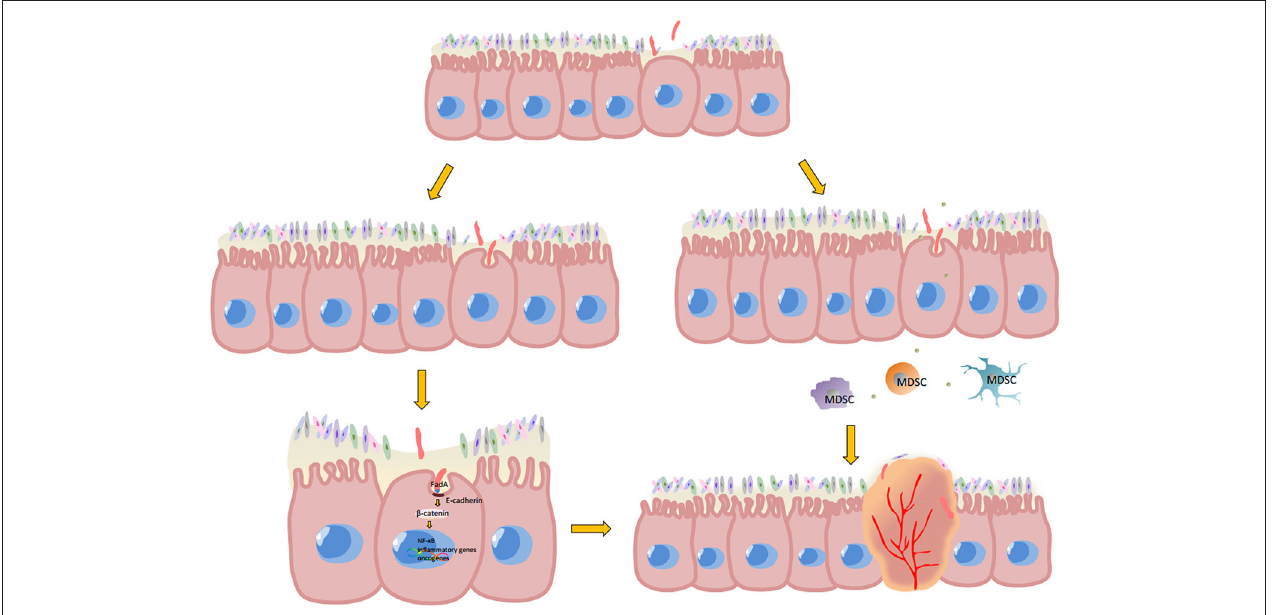
FIGURE 1 | Potential mechanism of Fusobacterium -associated CRC. Mutant epithelial cells cause local intestinal barrier impairment, which gives Fusobacterium the opportunity for adherence and subsequent invasion into epithelial cells. Once FadA, a membrane protein of Fusobacterium , combines with E-cadherin and is internalized by epithelial cells, the β -catenin signaling pathway is activated. Phosphorylated β -catenin would enter the cell nucleus from cytoplasm and promote NF- κ B genes, pro-inflammatory genes and the expression of many other oncogenes. Moreover, the microenvironment of malignancies is anoxic and acidic, which would be more suitable for Fusobacterium reproduction compared to other bacteria. The metabolites of aggregated Fusobacterium. Then recruit MDSCs, in turn suppressing anti-tumor immunity and promote CRC